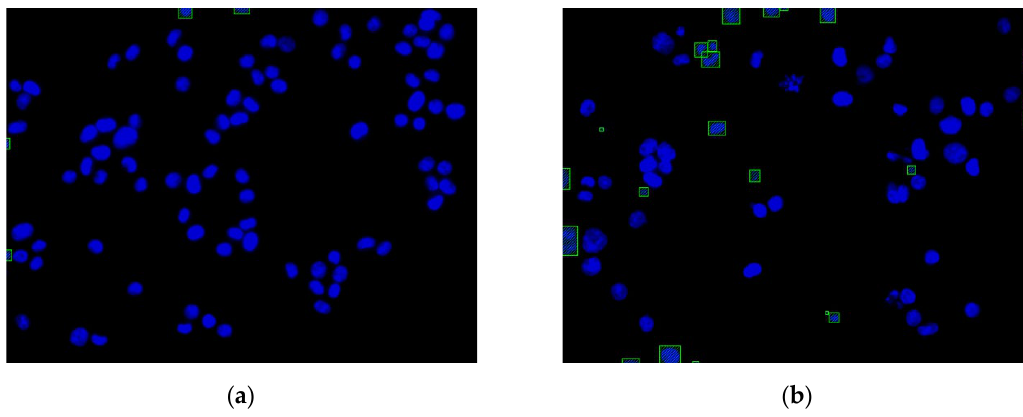
Figure 14. Invalid nucleus regions and regions in boundary detection by P (= N - B - D ) operation (rectangular box with diagonal lines): ( a ) HCT116 cell with DMSO (no.4484); ( b ) HCT116 cell with dinaciclib (no.4496).